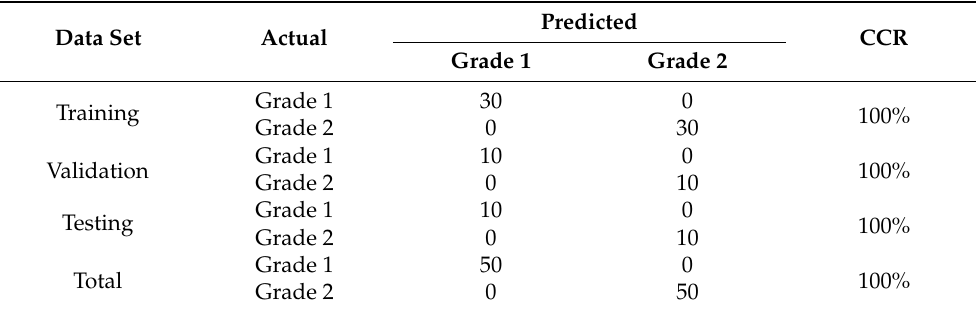
Table 3. The confusion matrix of the optimum classifier (ANN with 23-14-2 structure). Grades 1 and 2 represent the number of high- and low-quality samples, respectively.